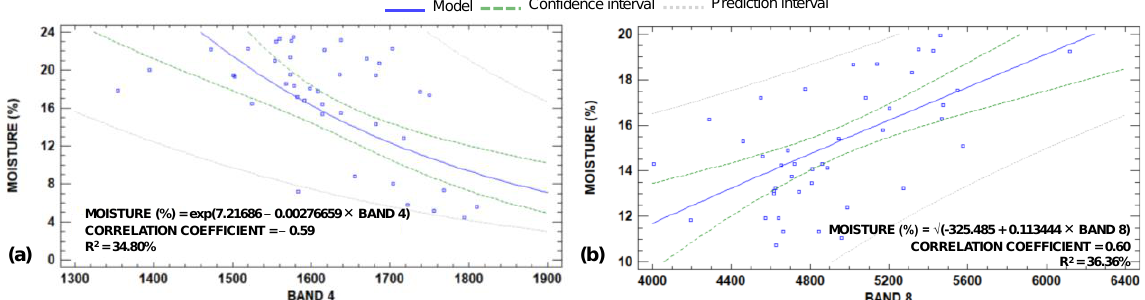
Figure 4. Simple Regression Models for ( a ) clay soil and ( b ) sandy soil for bands with 10 m of resolution.